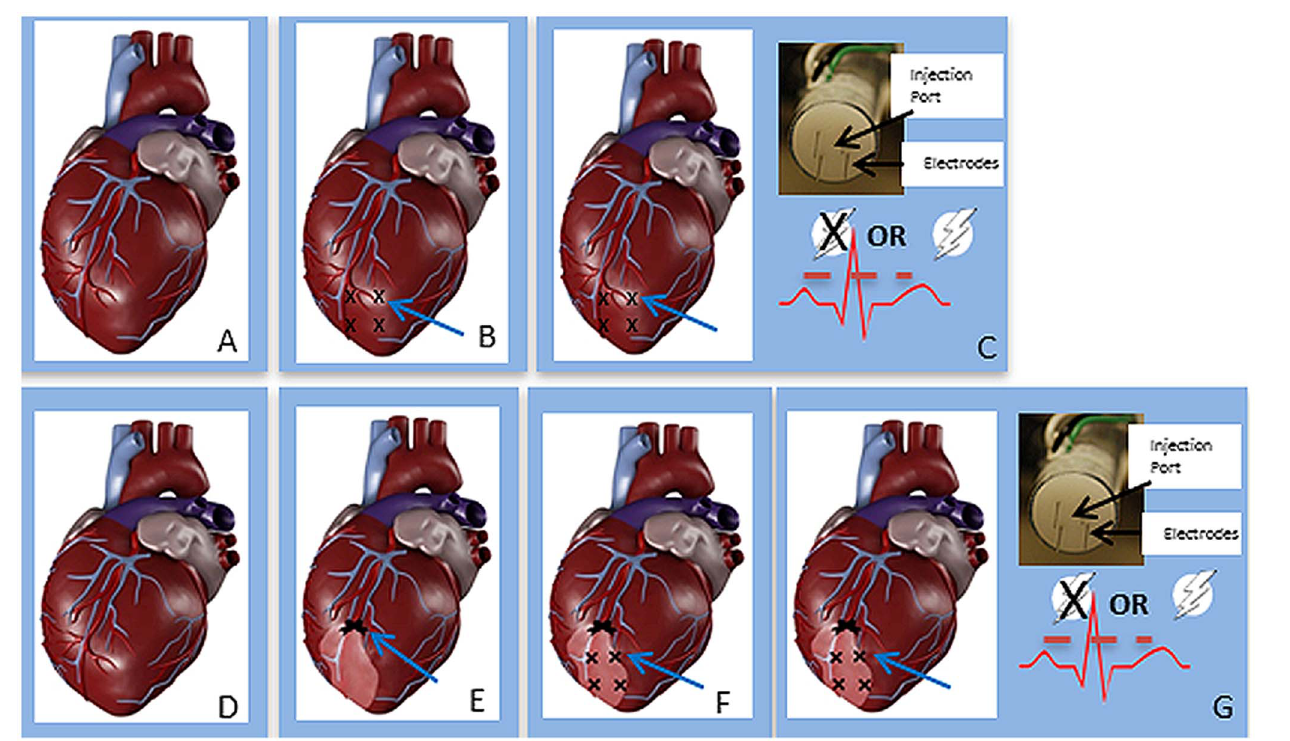
Fig. 1. Sequence for administration of therapy. A) The heart was exposed as described in the Methods section under ‘‘surgical procedure’’. B) The left anterior descending coronary artery is ligated with a permanent suture (arrow) and a SPY image is collected to visualize change in perfusion. C) Sutures are placed to designate the treatment sites. D) Sequence of treatment, applicator containing 4 electrodes and injection port is placed at the treatment site marked by suture; 100 m l of plasmid solution at a concentration of 2 mg/ml is injected; 8 pulses are administered. Procedure is repeated for the other 3